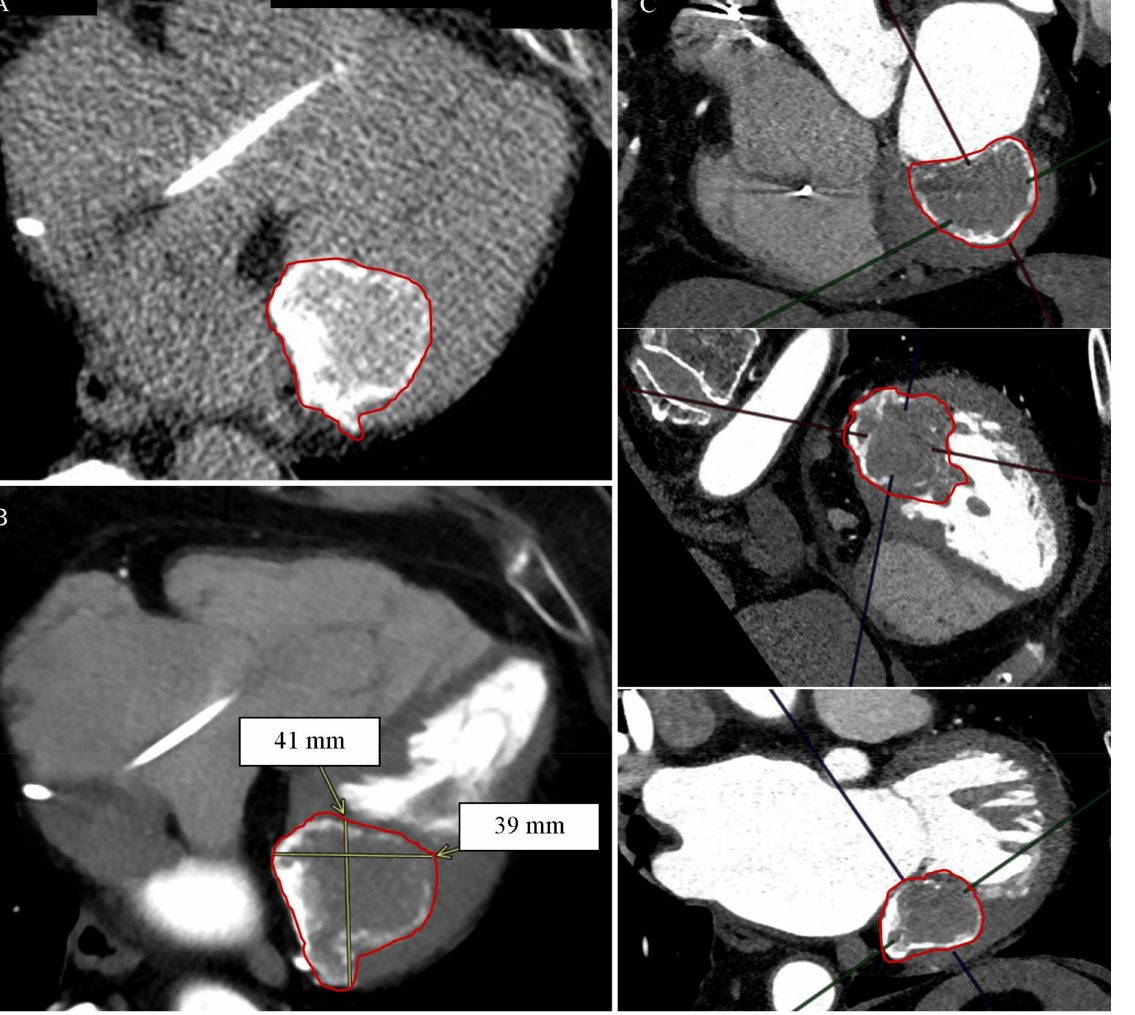
Figure 2. Patient No. 2. Caseous calcification of the mitral annulus (CCMA) in cardiac computed tomography. ( A ) Native phase. Axial reconstruction. The borders of the CCMA are marked in